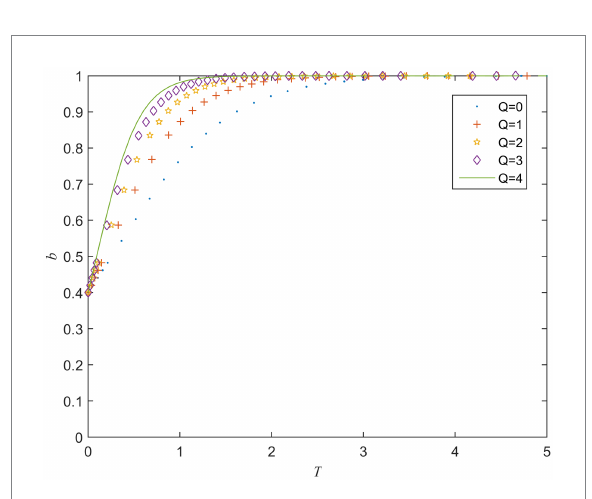
FIGURE 4 Strategy evolution of the private sector under different values of Q